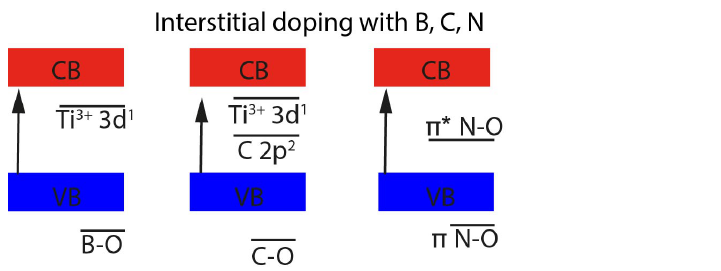
Figure 6. Schematic representation of the energy levels for interstitial doping in TiO 2 . Fan et al. doped TiO 2 with C which shifted the onset of the absorption curve of the doped sample to about 700 nm. The doped TiO 2 was able to degrade 60% of the methyl orange ( λ > 400 nm) in a test after half an hour, while the undoped TiO 2 showed negligible